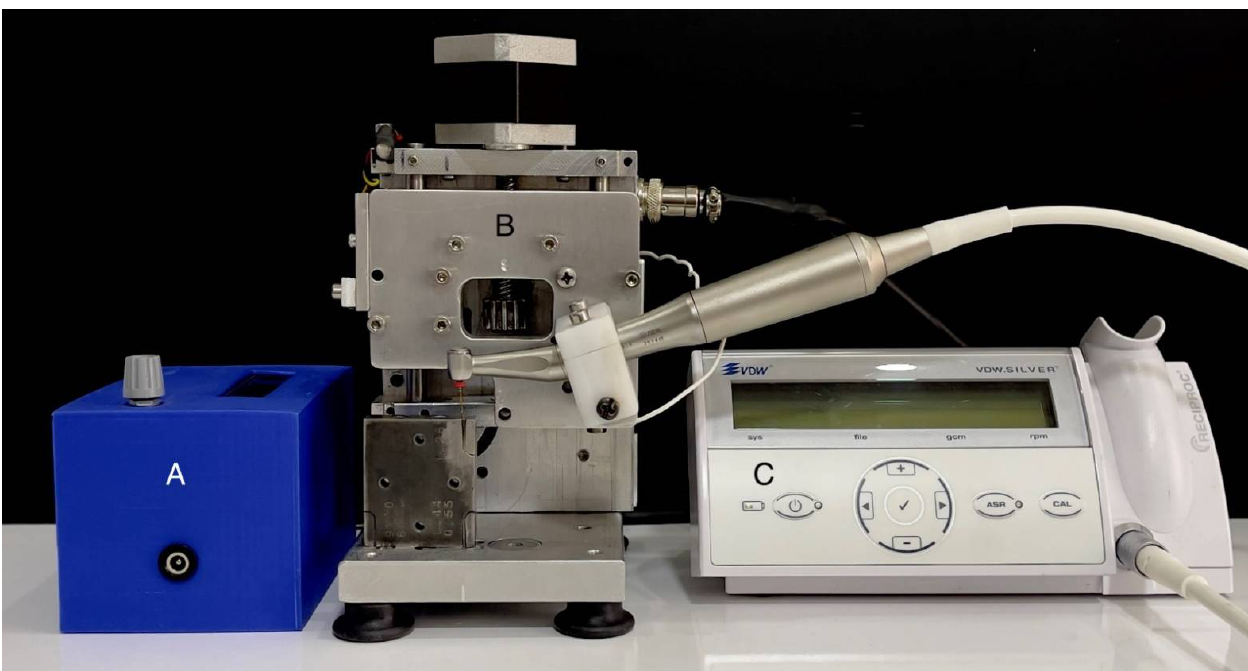
Figure 1. Dynamic cyclic fatigue test setting: ( A ) control panel, ( B ) dynamic device and artificial canal, and ( C ) VDW Reciproc Silver.